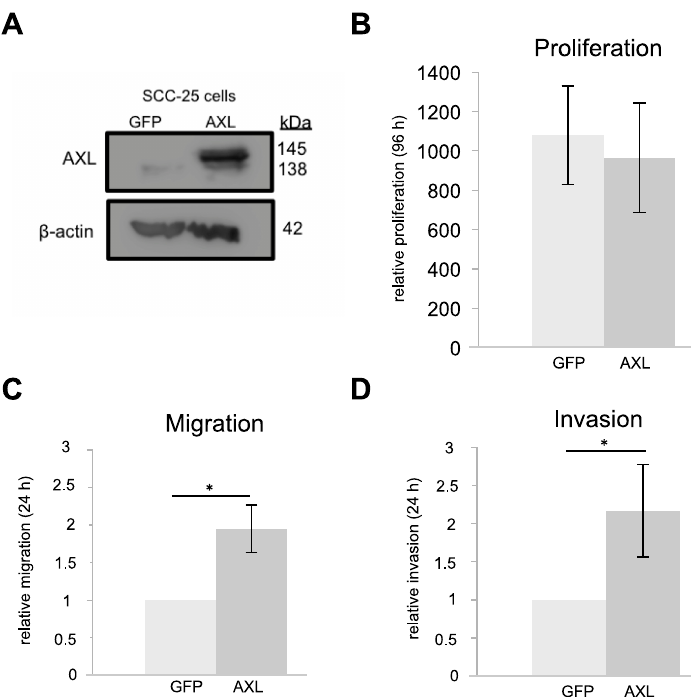
Figure 2. AXL overexpression in SCC-25 cells. ( A ) AXL overexpression in SCC-25 cells compared to GFP control cells. In the overexpression cells, the double band indicates expression of both endogenous AXL and GFP-tagged AXL; ( B ) relative proliferation of AXL overexpression and GFP control cells ( n = 3); ( C ) relative migration of AXL overexpression and GFP control cells ( n = 3); and ( D ) relative invasion of AXL overexpression and GFP control cells ( n = 3). ( B – D ) two-tailed paired t -test, * p < 0.05). GFP, green fluorescent protein.